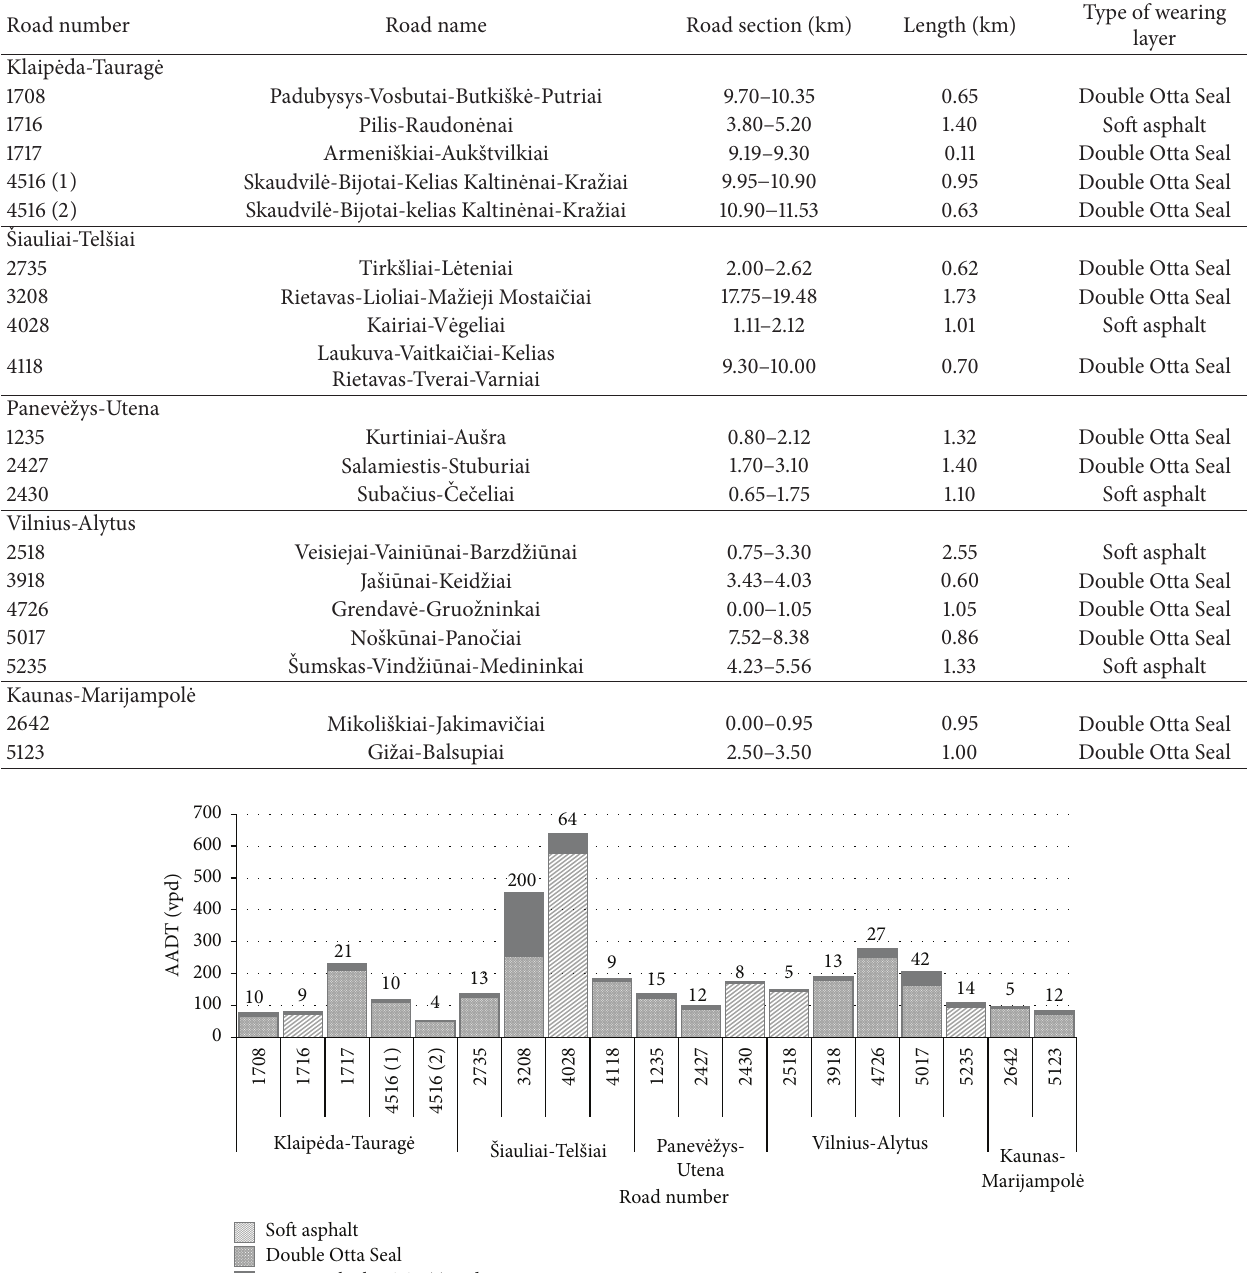
Table 1: Experimental roads sections of soft asphalt and double Otta Seal.